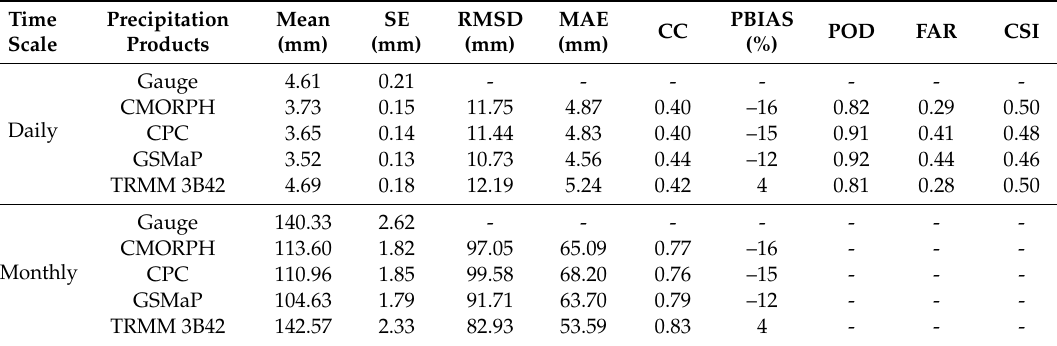
Table 4. Average indexes of the rain gauge observations and precipitation products, at both the daily and the monthly time